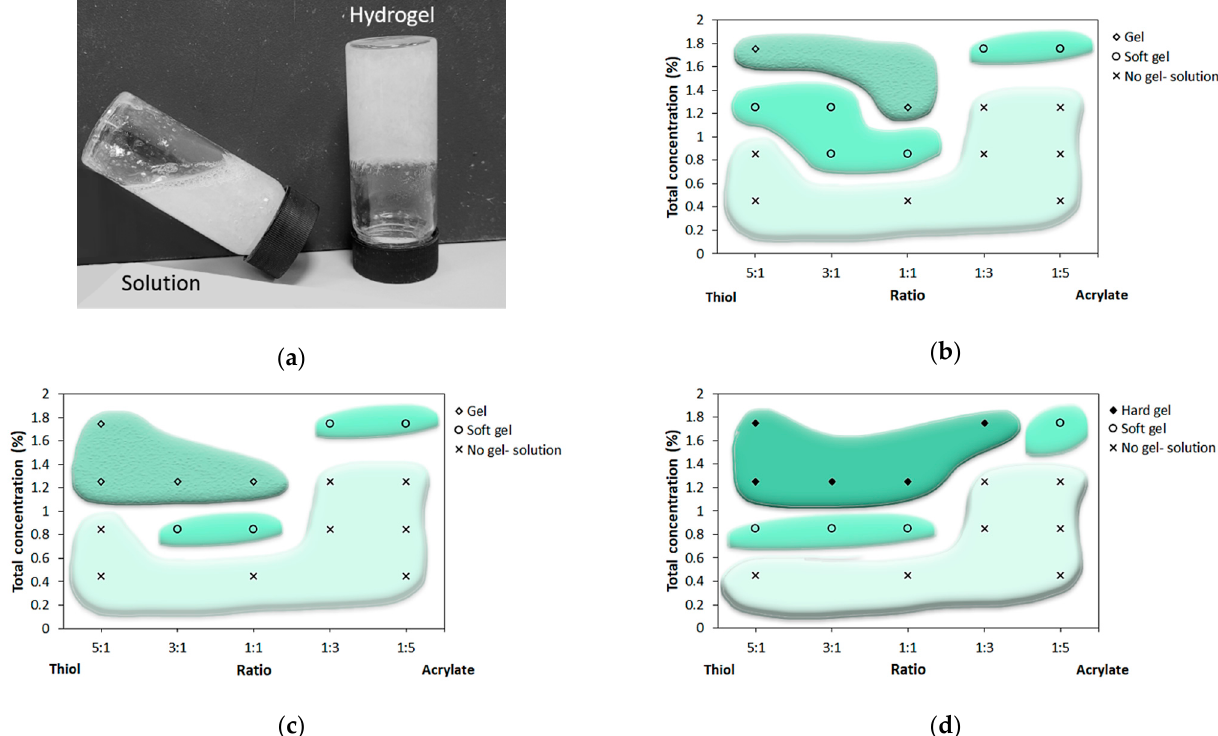
Figure 1. ( a ) The vial tilting method representing a “solution” phase and a “hard gel” phase. Phase diagram of the pectin-thiol and chitosan-acrylate hydrogels in a fixed pH value of 5.6 after curing for ( b ) 72, ( c ) 120 , and ( d ) 160 h. n = 3.